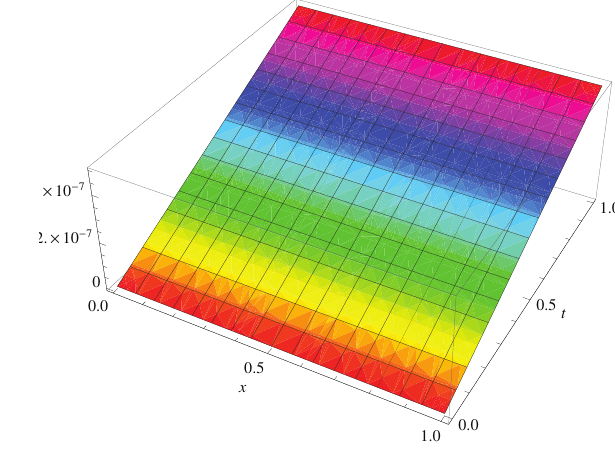
Fig. 4: Plot of absolute error E 3 = | u ( x , t ) − u 3 ( x , t ) | .